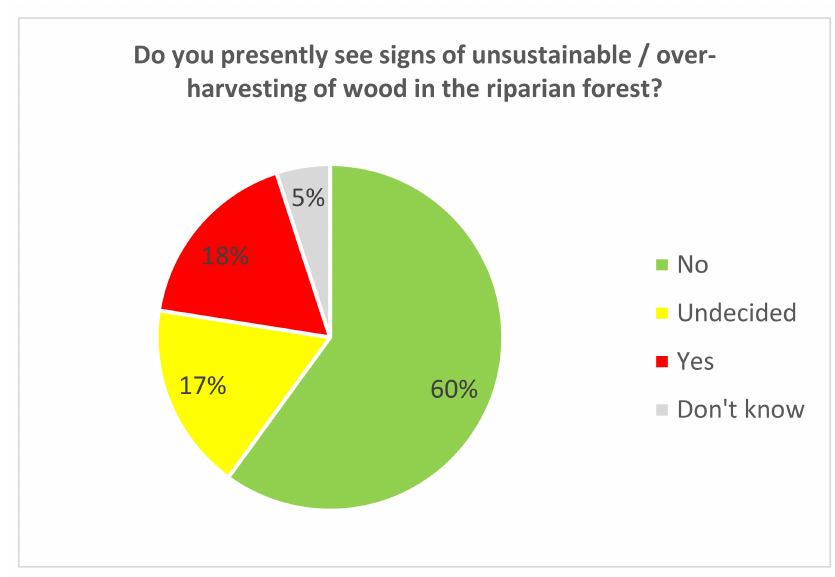
Figure 7. Wood over-harvesting assessment by inhabitants of Ak-Tal Village (Ak-Tal HHS 2020). The recognition of fuel wood over-harvesting does not show significant correlations either with (a) the amount of fuel wood used or with (b) wealth or with (c) the distance between home and forest, or with any other researched